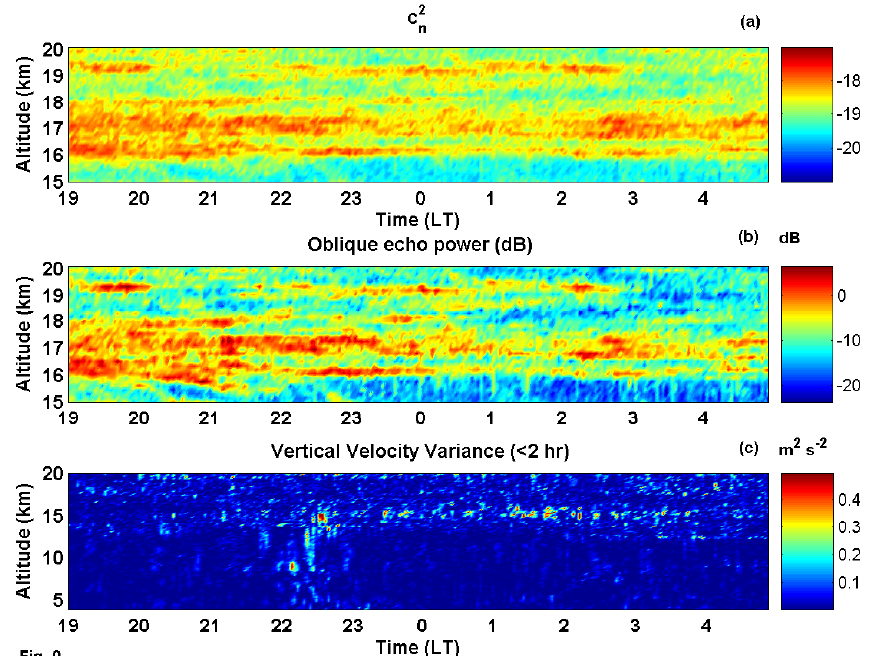
Fig. 9. Contours of C 2 n (a) and echo power (b) between 15 and 20km for ∼ 10h from 19:00–04:55LT. Short-period vertical wind variance for the altitude range from 500m–20km and for the same interval of time (c) .